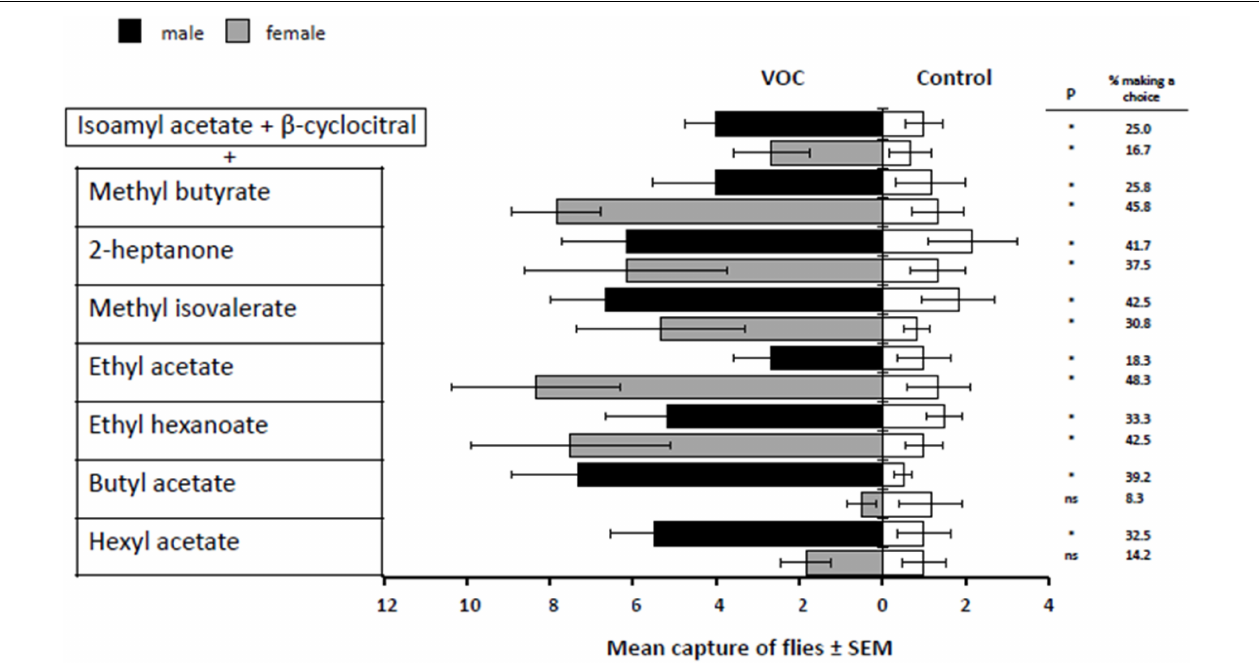
FIGURE 1 | Response of male and female D. suzukii to mixtures of one fruit volatile added to isoamyl acetate and β -cyclocitral (VOC) against the mineral oil solvent (Control). P -values with ∗ indicate P < 0.05 and “ns” indicates a non-significant difference where P >